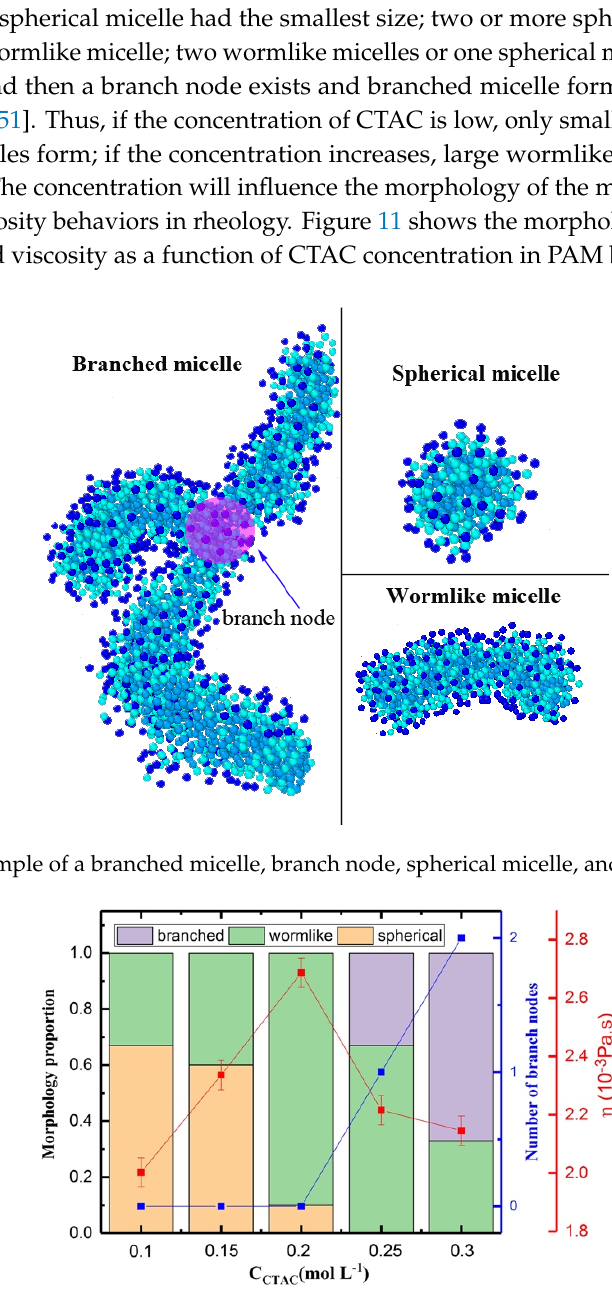
Figure 11. Results for the morphology proportion, number of branch nodes, and viscosity as a function of CTAC concentration.